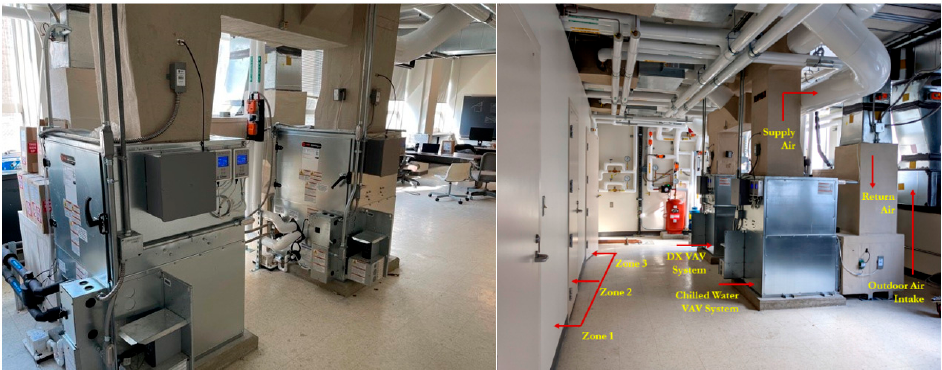
Figure 10. Photos of DX and chilled-water VAV systems in the HVAC Lab at the University of Cincinnati.